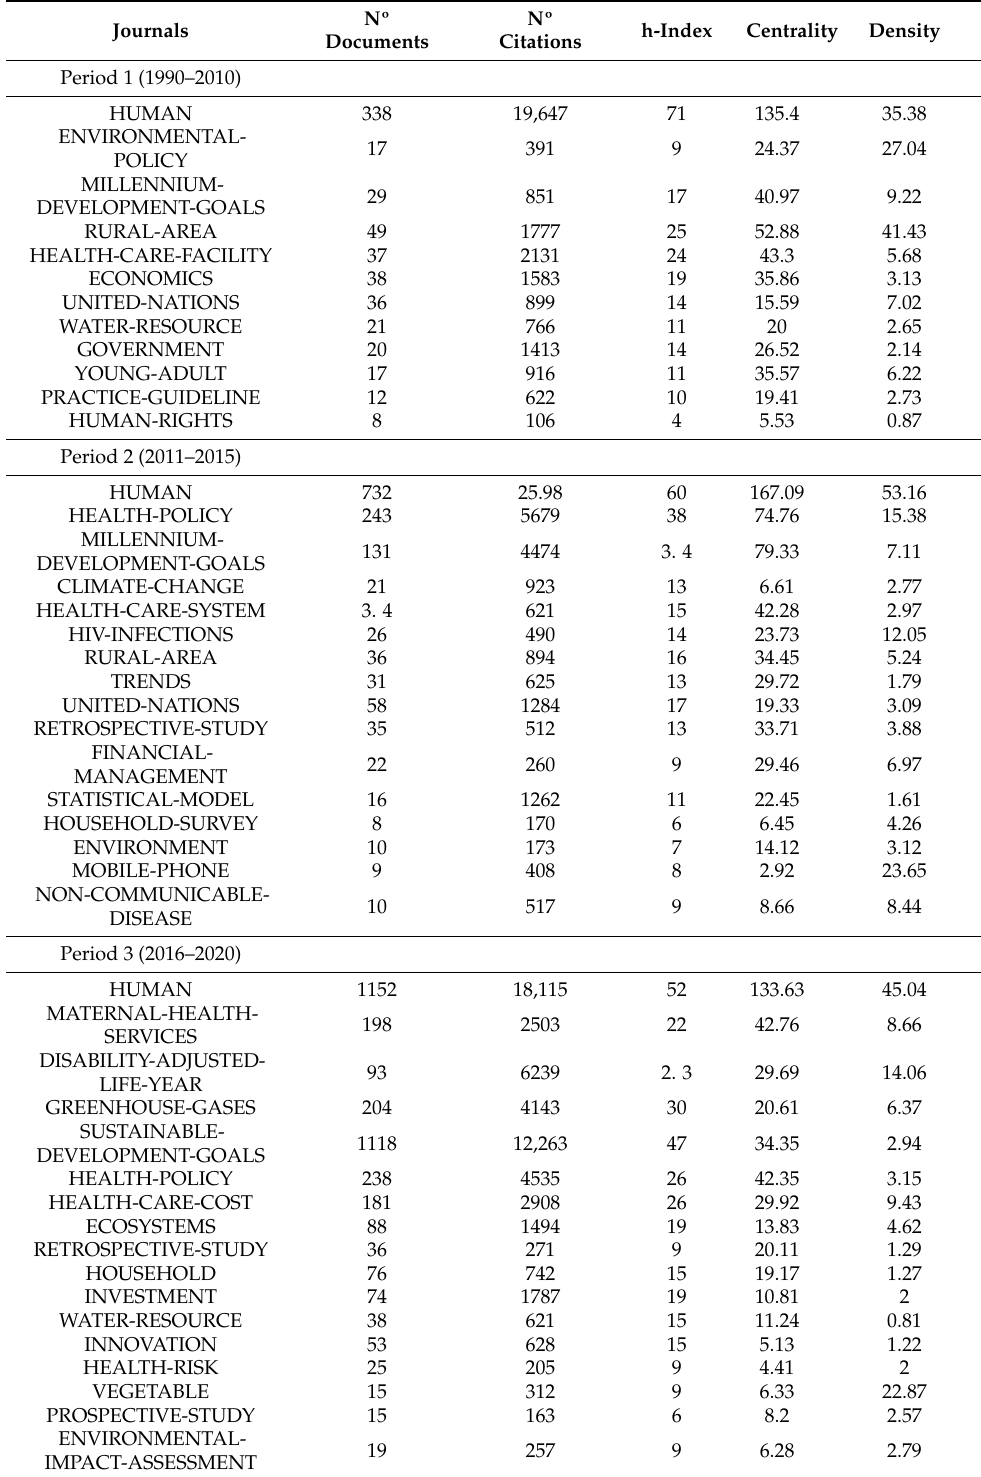
Table 1. Performance measures of the